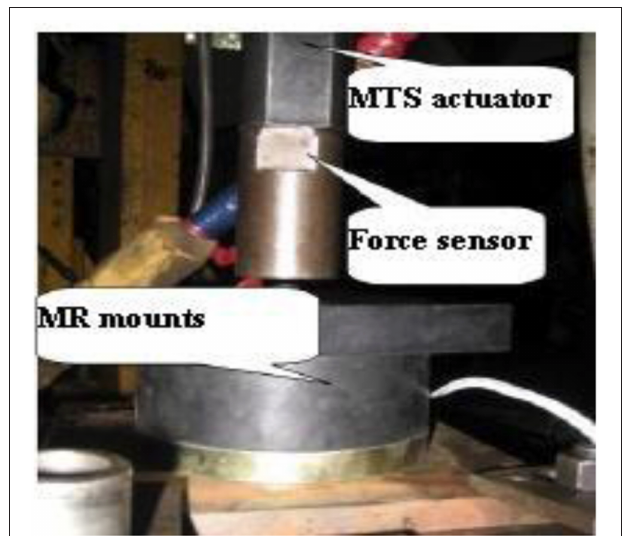
FIGURE 7 | Testing platform of MR